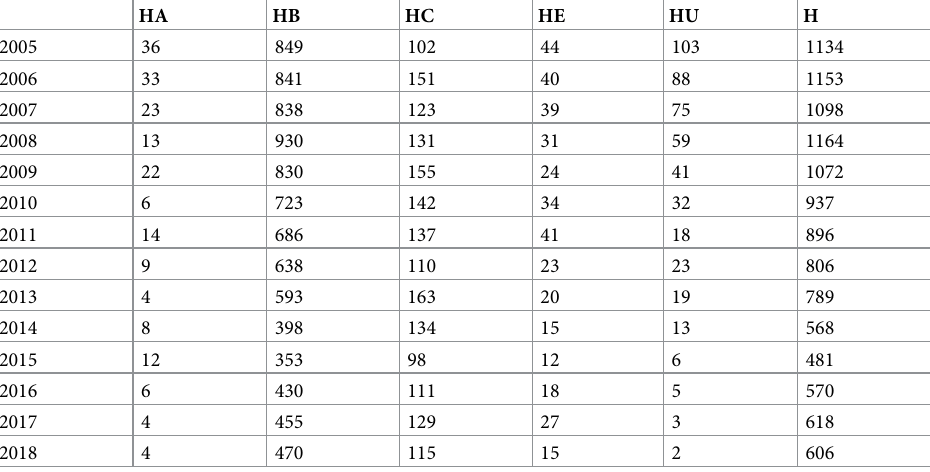
Table 2. Numbers of deaths caused by hepatitis diseases in China. HA